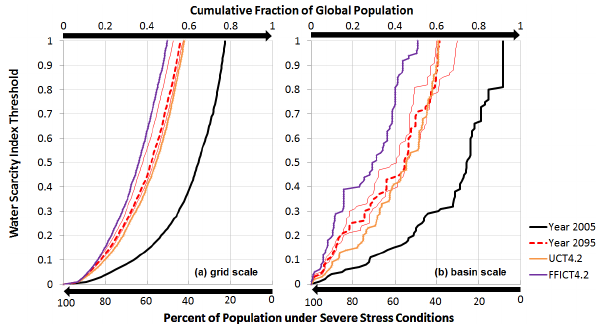
Figure 17: Shifts to the cumulative probability density function of the fraction of global population living under different levels of scarcity (WSI); water scarcity is estimated at the grid (a) and basin (b) scales; the thin lines reflect the uncertainty corresponding to any one of the four GCMs instead of the ensemble mean